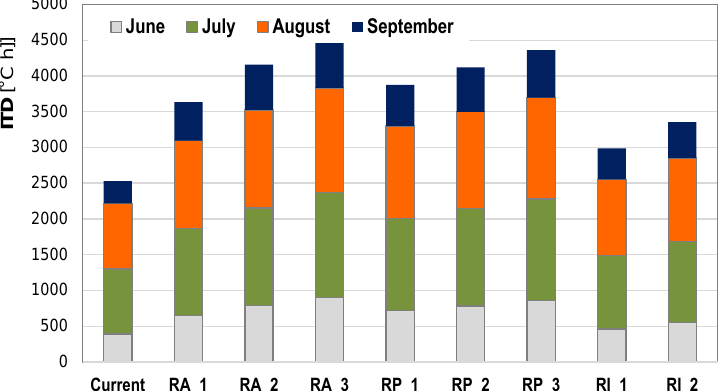
24262830323436 Figure 6. Operative temperature profile on the hottest day (9th of August, East-facing office). Figure 7. Intensity of thermal discomfort for the proposed retrofit